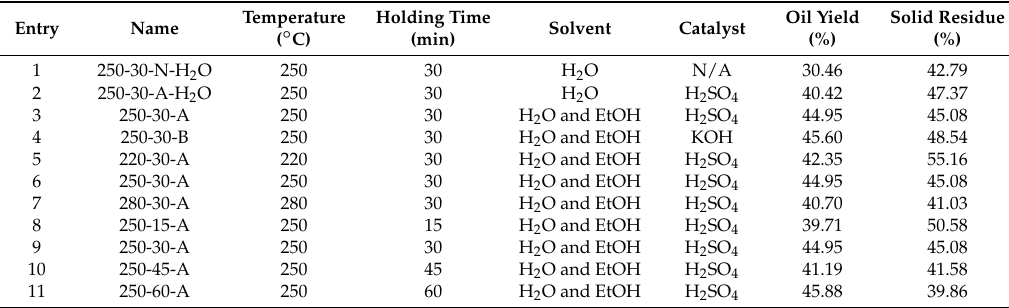
Table 2. Experimental design